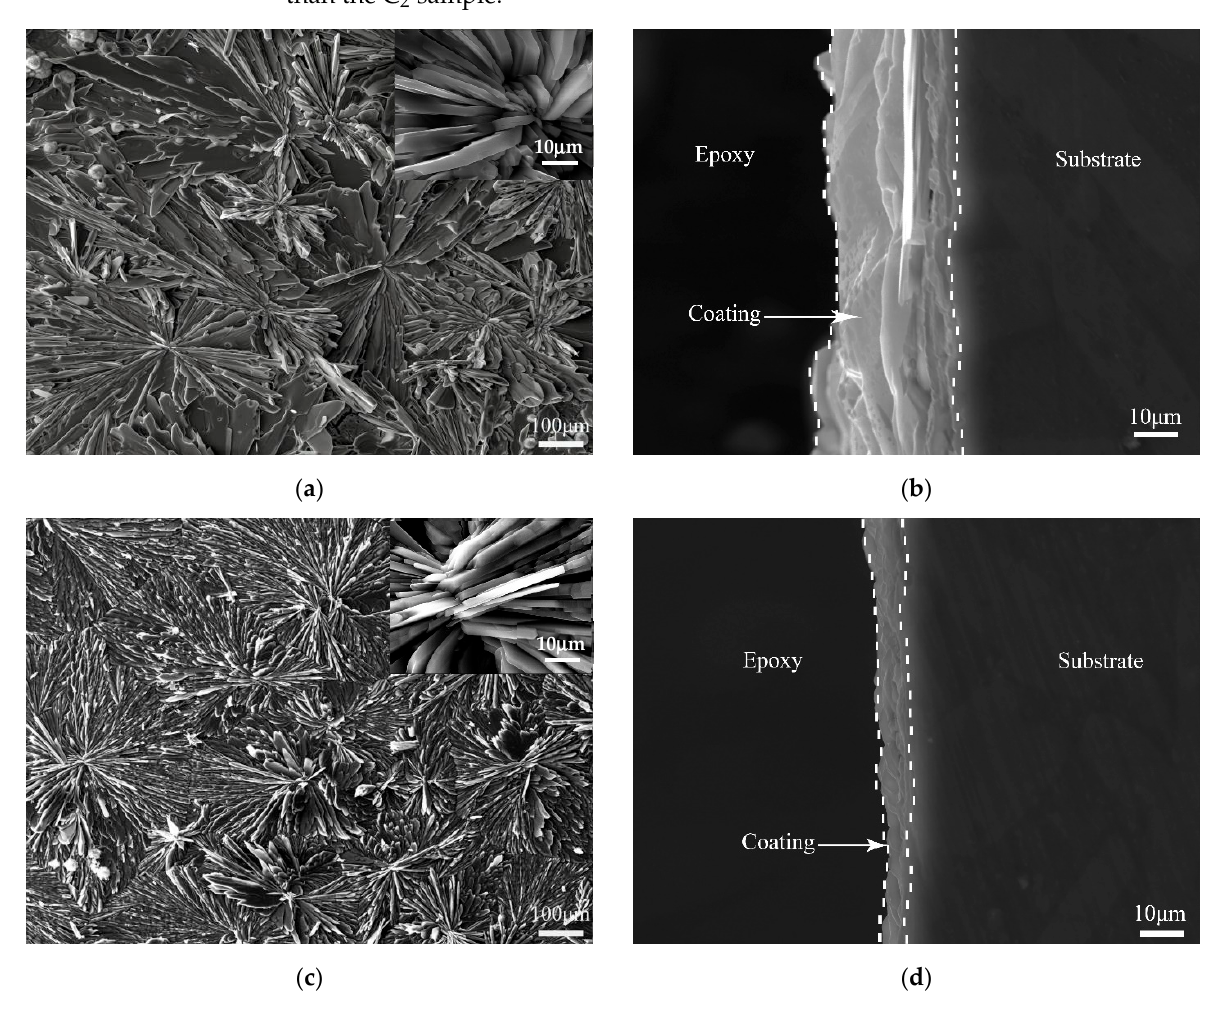
Figure 1. SEM observations: ( a ) and ( c ) surface morphologies of C 1 and C 2 samples, ( b ) and ( d ) cross-sectional morphologies of C 1 and C 2 samples.